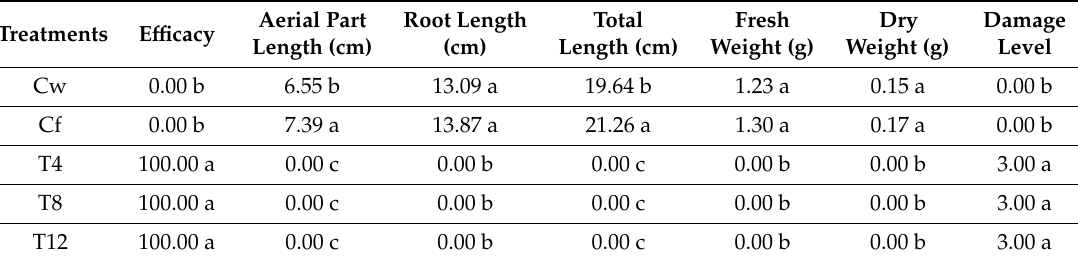
Table 8. E ffi cacy, e ff ects on several plant traits (aerial part, root and total length, fresh and dry weight), and damage level of TC4 EO at di ff erent application doses on P. oleracea . T4, T8, T12: 4, 8, 12 µ L / mL EO; Cw: water control; Cf: Fitoil control.